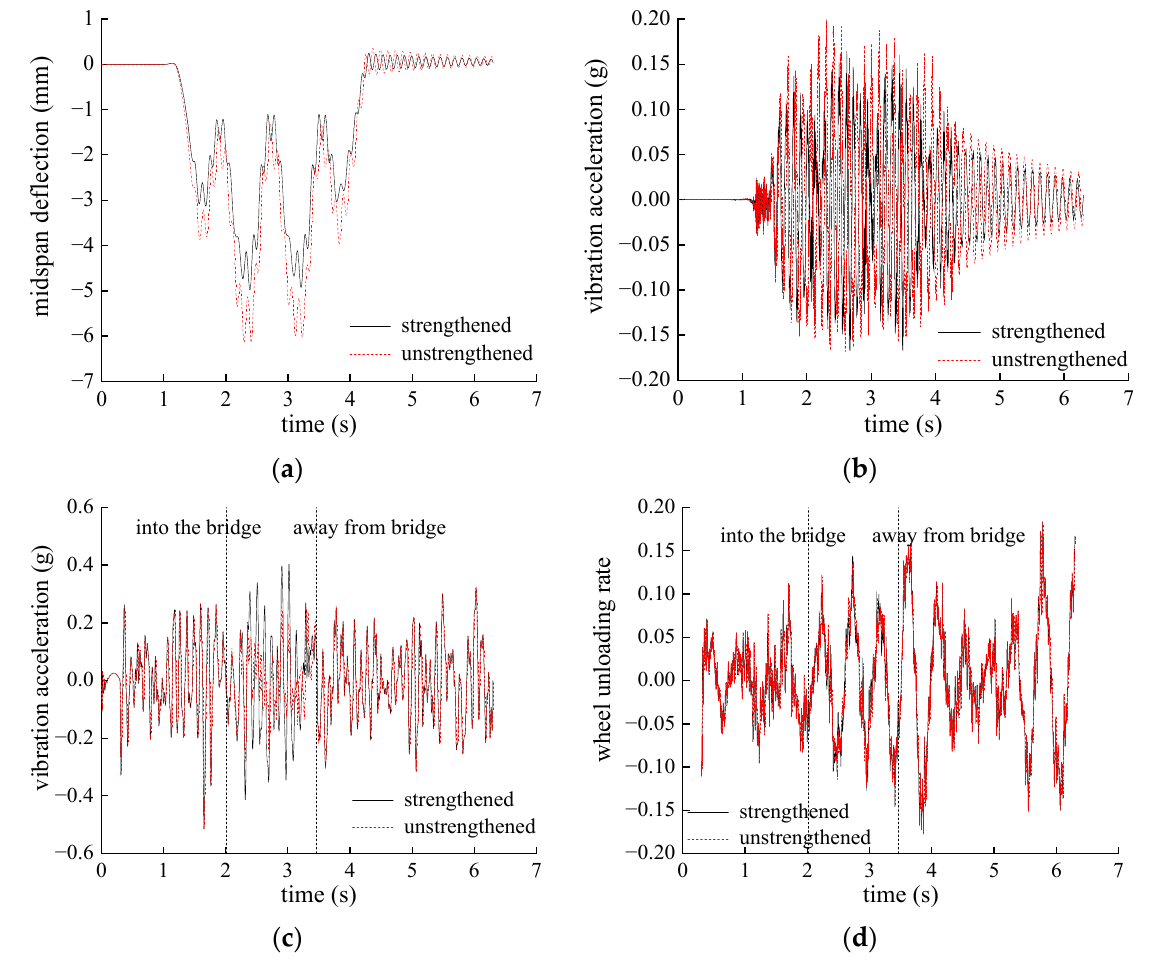
Figure 20. Dynamic responses. ( a ) Midspan deflection; ( b ) midspan’s vibration acceleration; ( c ) car’s vibration acceleration; ( d ) wheel unloading rate. vibration acceleration; ( d ) wheel unloading